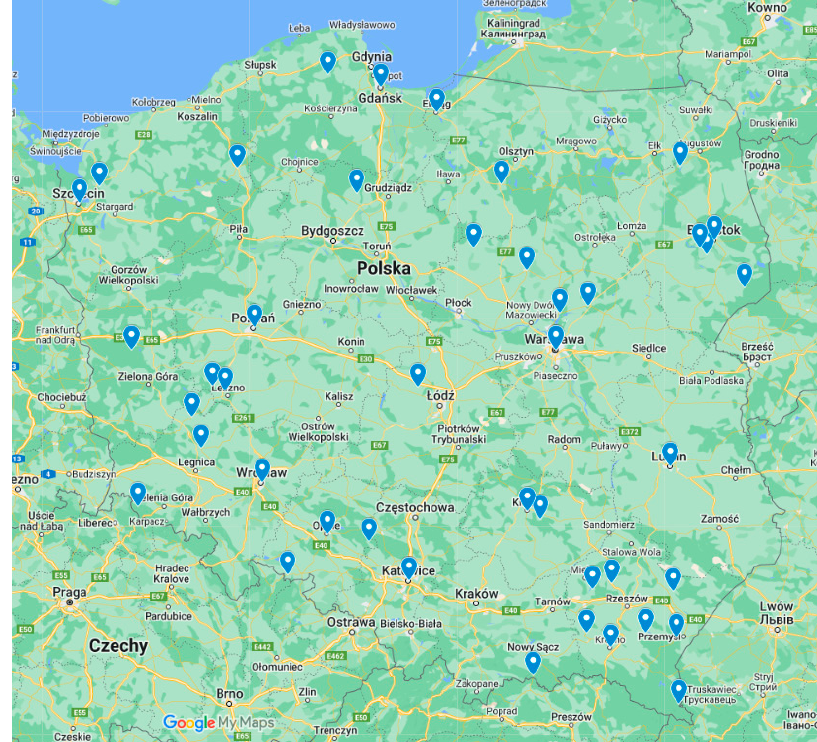
Figure 1. Group of participants in the pilot study by location in Poland. (Source: own).